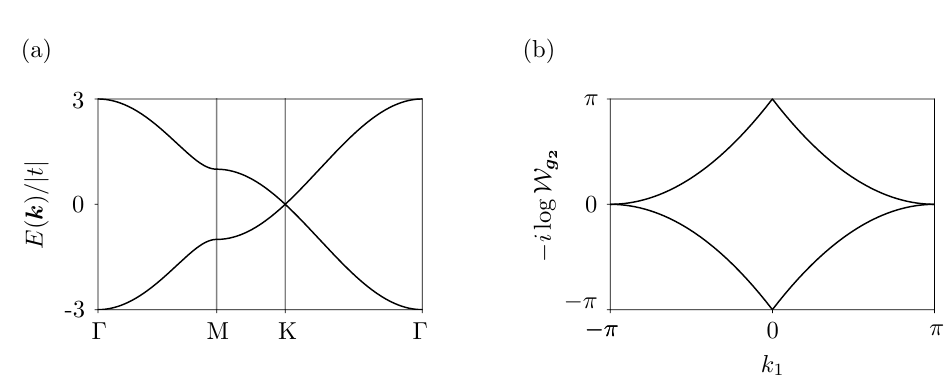
( k ) , after opening a gap at K with g 2 1